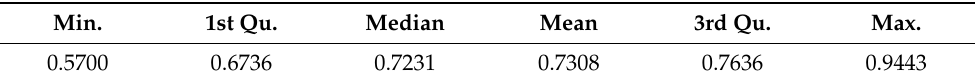
Table 5. The descriptive statistics of the similarity between the distance geometries of the cargo ships vs. passenger ships problem.